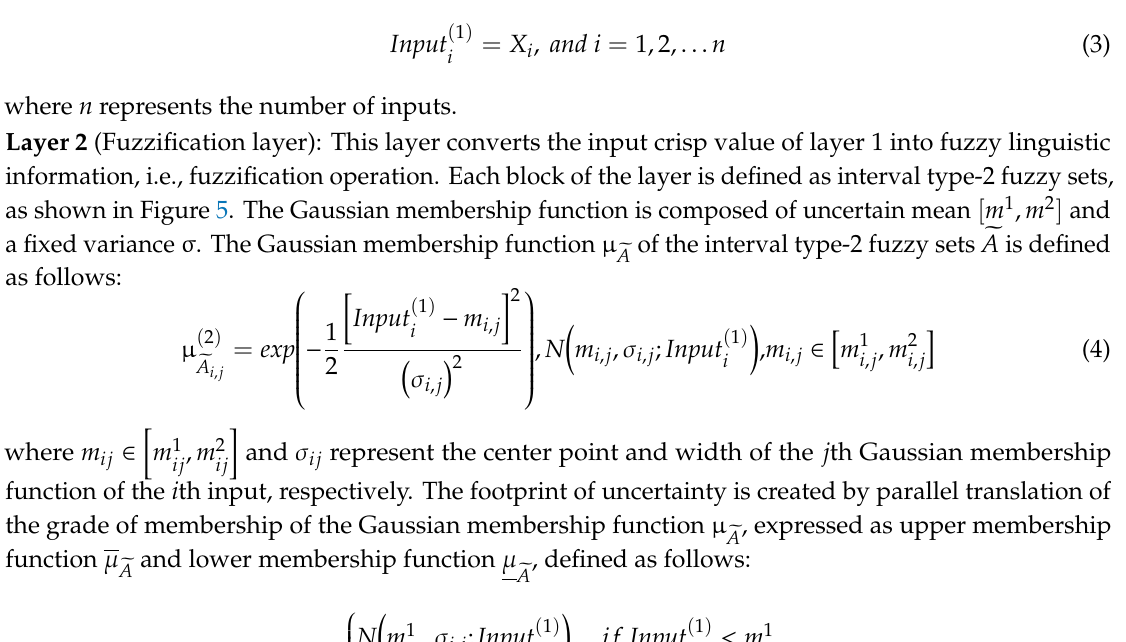
Figure 5. Interval type-2 fuzzy sets.